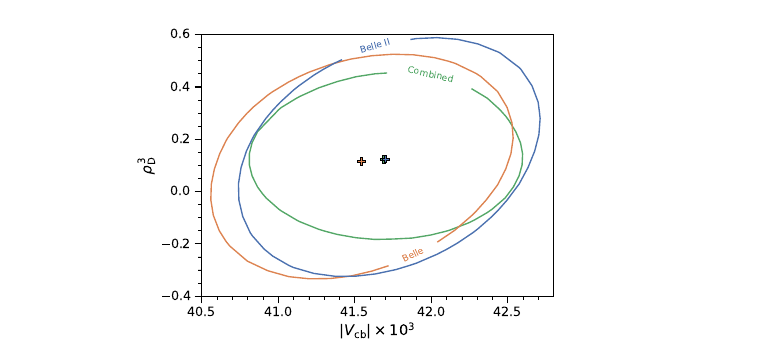
Figure 4 . Fit projections for the central q 2 moments as a function of the q 2 threshold, combined with the measurement moments from both Belle and Belle II.